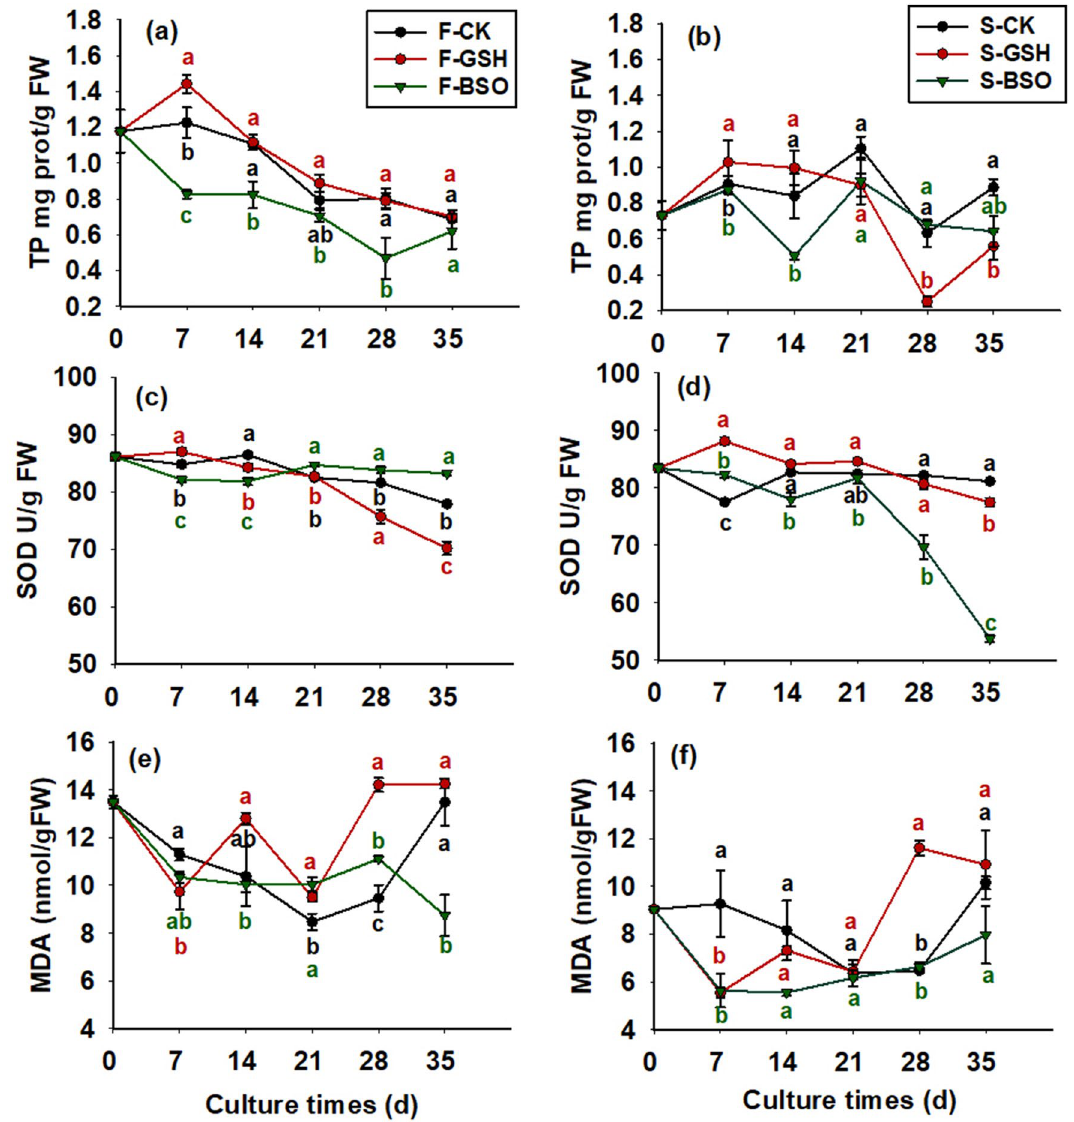
Figure 3. Effects of exogenous GSH and BSO on TP, SOD, MDA proliferation in two Korean pine cell